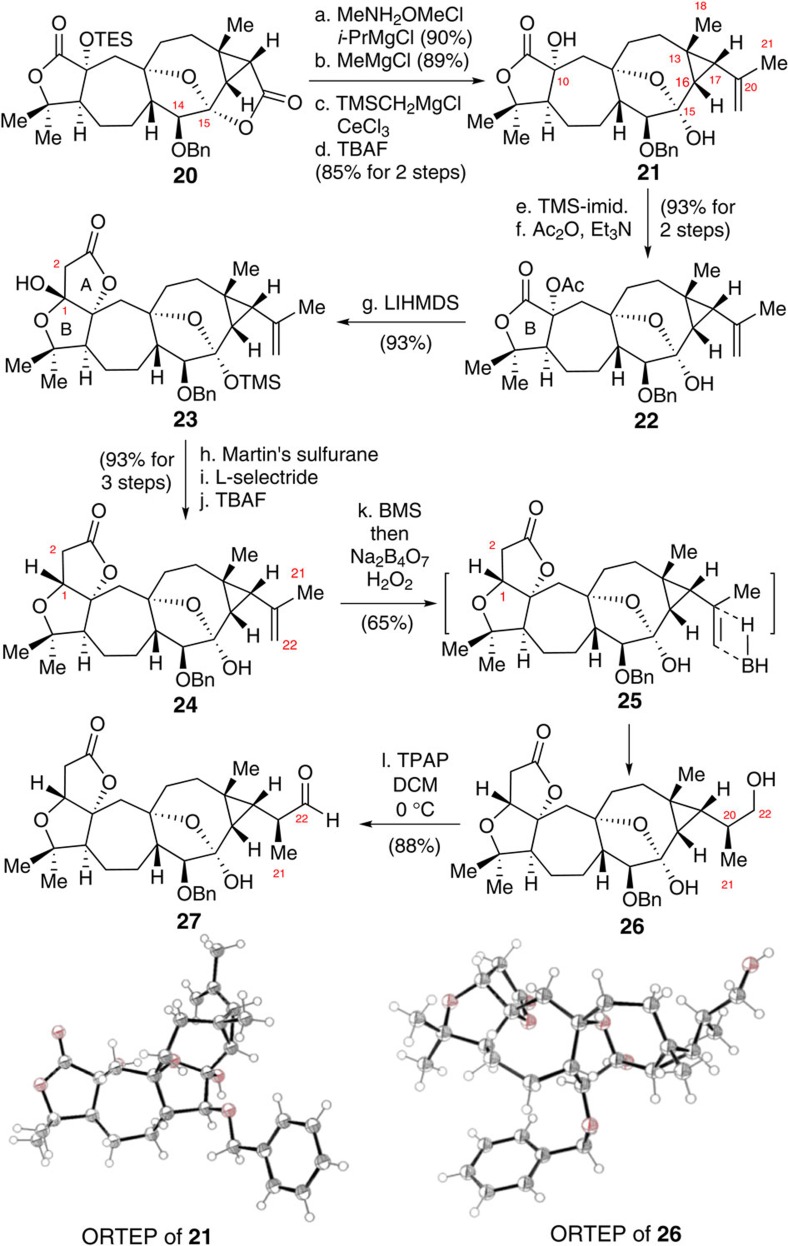
Synthesis of alcohol 27.(a) MeNHOMe·HCl (5.0 eq),iPrMgCl (10.0 eq), THF, −20 °C, 90%; (b) MeMgCl (3.0 eq), THF, 0 °C, 89%; (c) TMSCH2MgCl (5.0 eq), CeCl3 (5.0 eq), THF, 0 °C, then silica gel, DCM, 83%; (d) TBAF (3.0 eq), THF, 0 °C, 99%; (e) TMS-imid. (10.0 eq), DCM, 0 °C, 95%; (f) Ac2O (15.0 eq), DMAP (1.0 eq), Et3N (15.0 eq), PhMe, rt, 98%; (g) LiHMDS (3.0 eq), THF, −78 to −35 °C, 93% b.r.s.m.; (h) Martin's sulfurane (1.2 eq), DCM, rt; (i) L-selectride (3.0 eq), −78 °C; (j) TBAF (5.0 eq), THF, 0 °C, 93% in three steps; (k) BMS (10.0 eq), THF, 0 °C, 0.75 h, then Na2B4O7 (excess), H2O2 (excess), rt, 65%; (l) TPAP (1.3 eq.), DCM, 0 °C, 88%. BMS, borane-dimethylsulfide complex; b.r.s.m., based on recovered starting material; L-selectride, lithium tri-sec-butylborohydride; Martin's sulfurane, bis[α,α-bis(trifluoromethyl) benzenemethanolato]- diphenylsulfur; TBAF, tetra-n-butylammonium fluoride; TMS-imid., 1-(trimethylsilyl)-1H-imidazole; TPAP, tetra-n-propylammonium perruthenate(VII).